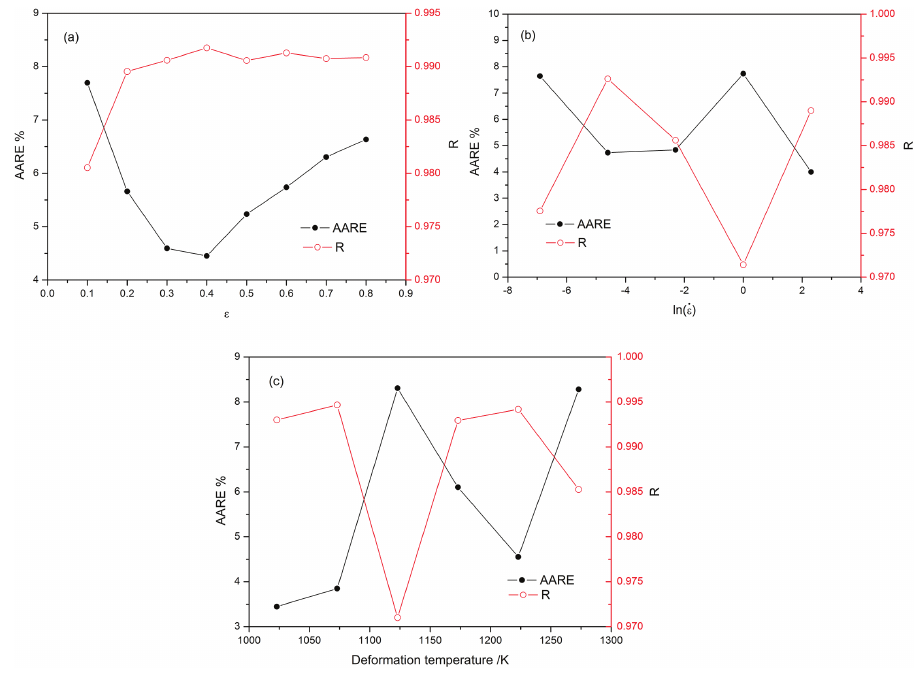
Figure 15: Variation between AARE and R with (a) strain, (b) strain rate and (c) deformation